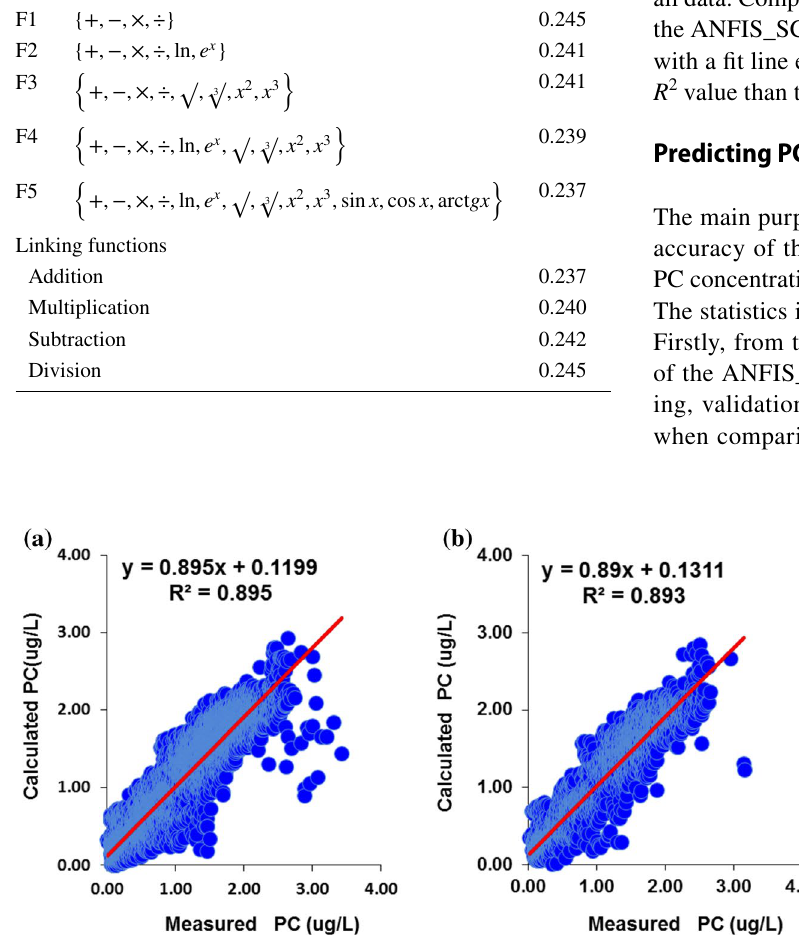
Fig. 3 Scatterplots of estimated versus measured values of PC for FFNN (M1) model: a training, b validation and c test data—station ID: